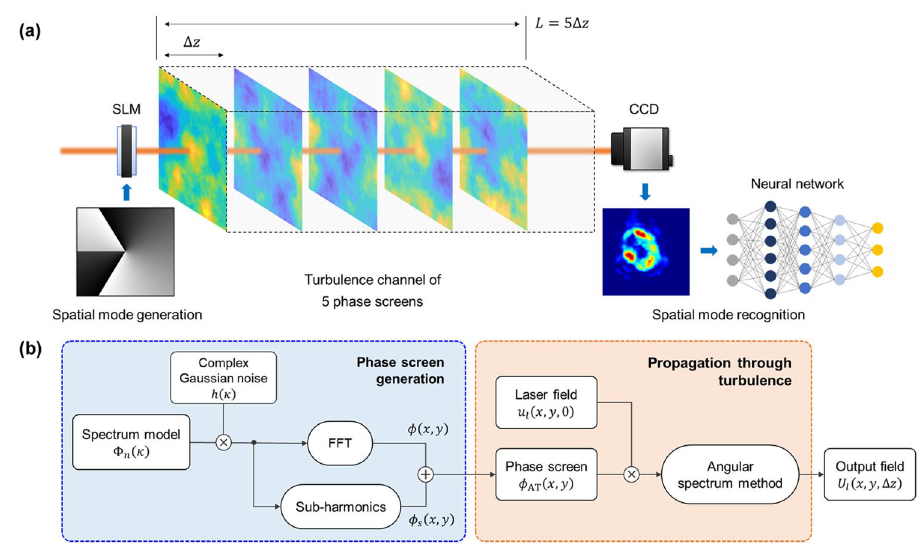
Figure 1. Schematic diagrams for investigating AT effects. ( a ) Geometry of the simulation model and ( b ) a flowchart for numerical simulation of laser beams propagating through AT media. Each inset in ( a ) displays the phase hologram (left) and intensity profile (right) of fractional OAM mode l = 1.50 , respectively.